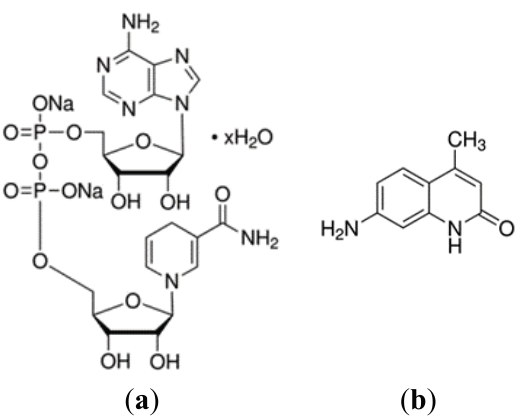
Figure 2. Structures of the fluorophores ( a ) NADH (reduced form of nicotinamide adenine dinucleotide) and ( b ) Carbostyril 124 (7-amino-4-methyl-2(1 H )-quinolinone).